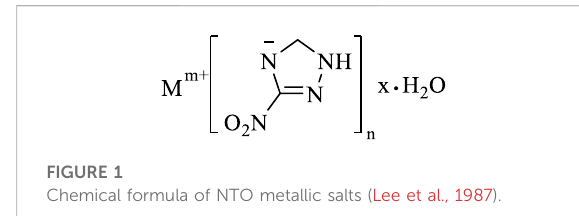
FIGURE 1 Chemical formula of NTO metallic salts (Lee et al.,